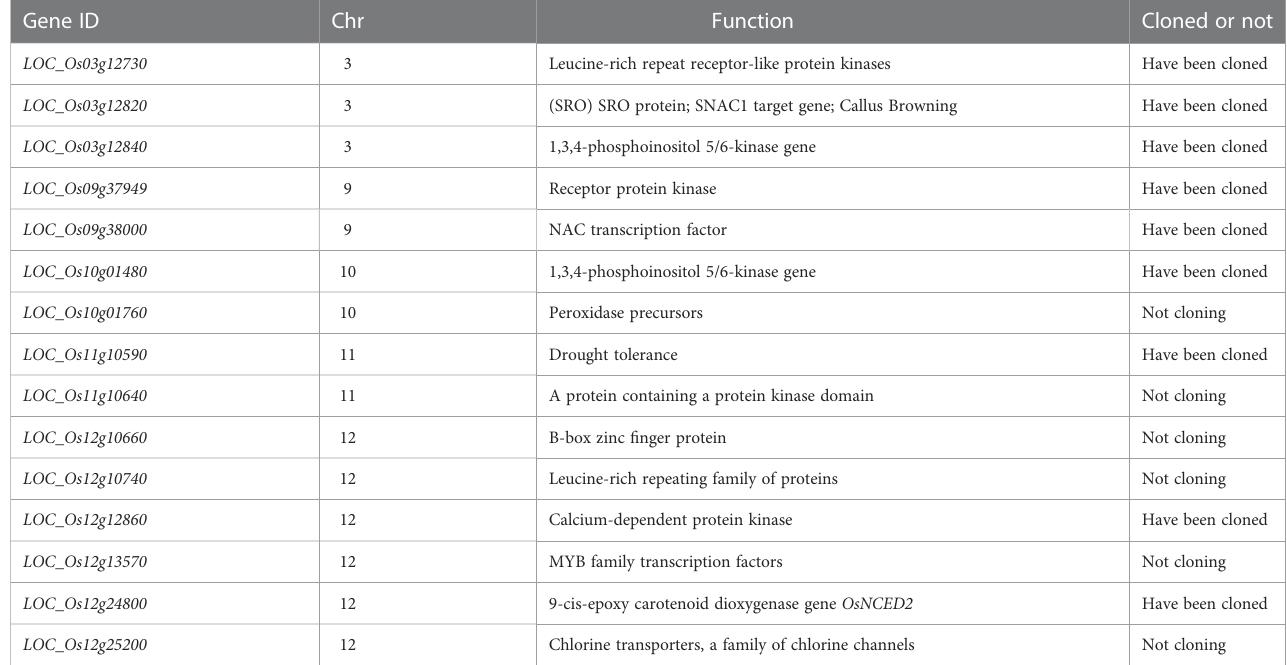
TABLE 2 Functional analysis of candidate genes in QTL mapping interval. Gene ID Chr